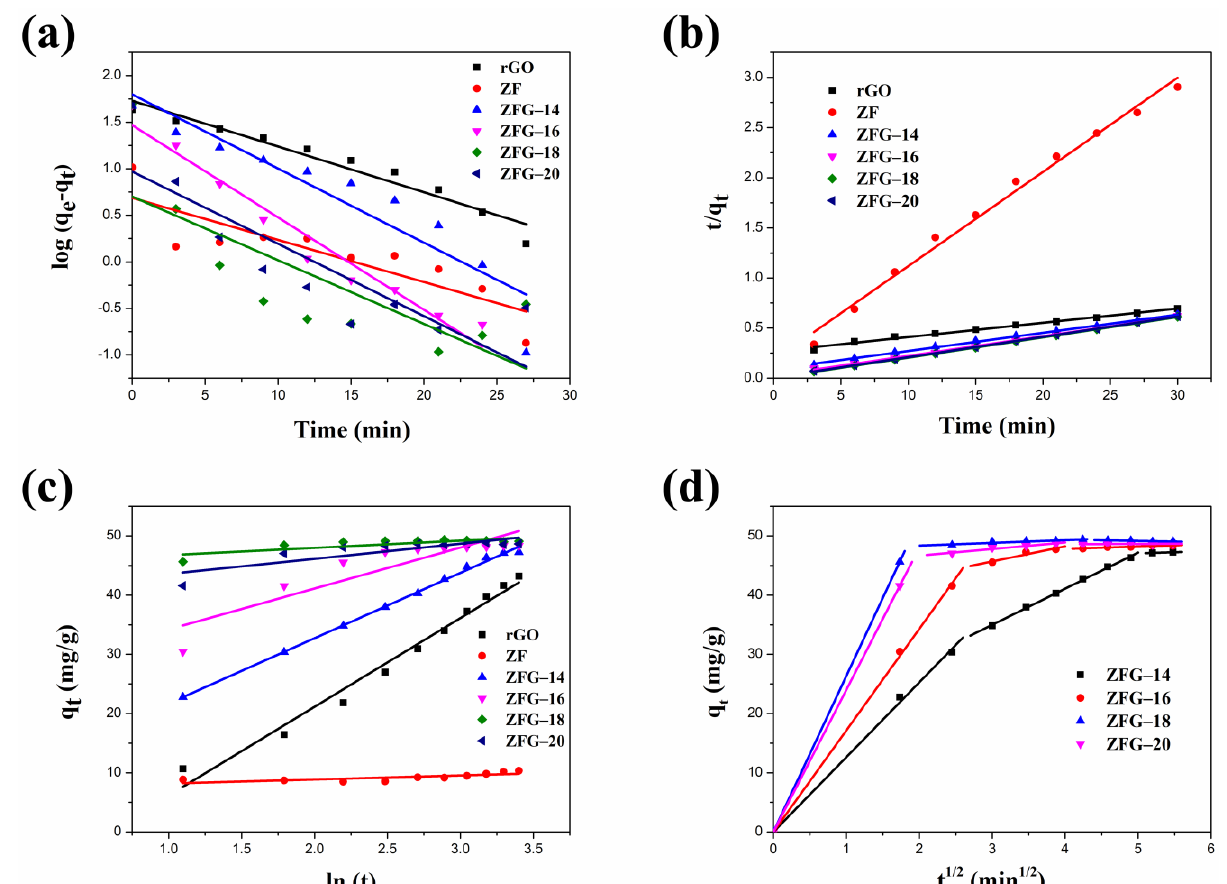
Figure 7. Different kinetic fitting models of MB dye adsorption ( a ) pseudo-first-order ( b ) pseudo-second-order ( c ) Elovich; ( d ) intra-particle diffusion model of ZFGs. Conditions: adsorbent dosage = 10 mg, MB concentration = 10 mg L −1 , T = 295 K.